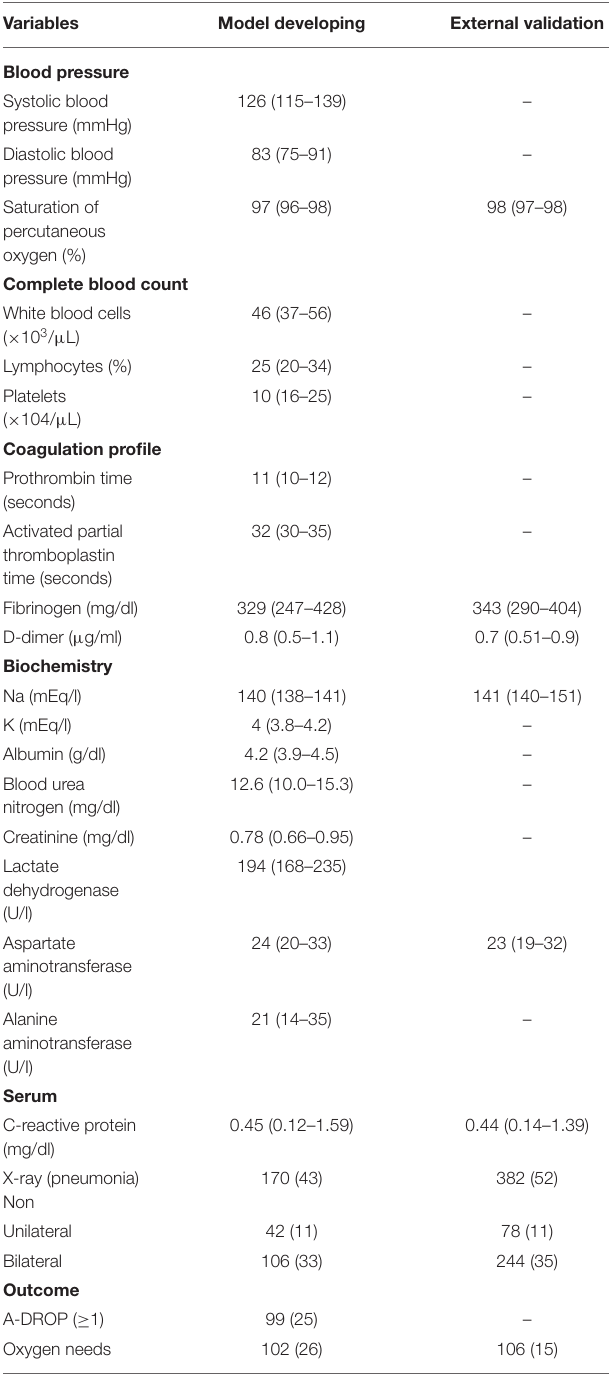
TABLE 2 | Blood pressure, percutaneous oxygen saturation, laboratory findings, X-ray on admission, and outcome of the patients with COVID-19.